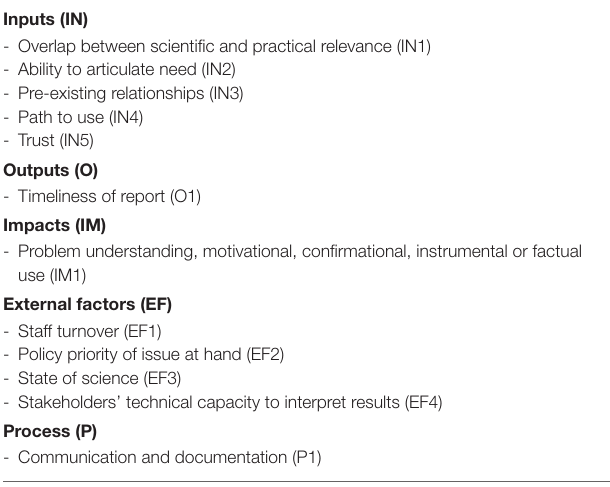
TABLE 3 | Important factors in HazardSupport co-design process, based on components in the Wall et al. (2017) evaluation framework of knowledge co-production